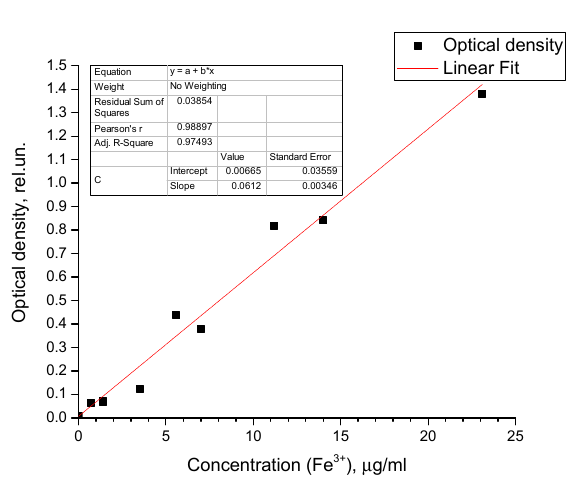
Figure A1. Calibration curve for the Fe 3+ concentration determination.